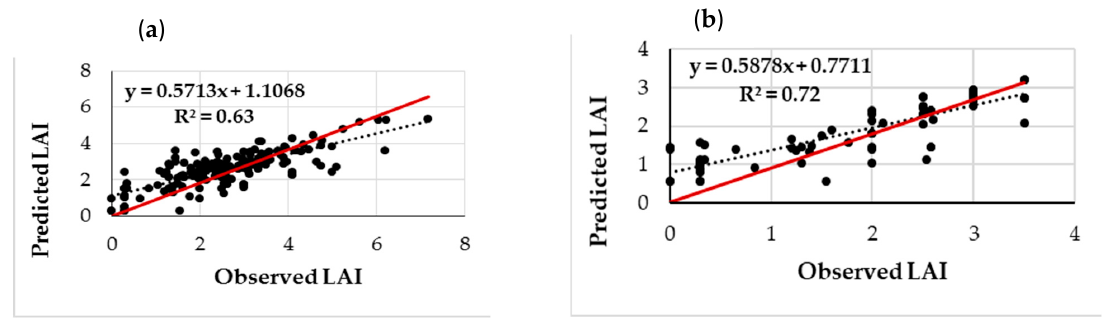
Figure 5. Observed vs. predicted LAI using RF-optimized models: ( a ) wet season data; ( b ) dry season